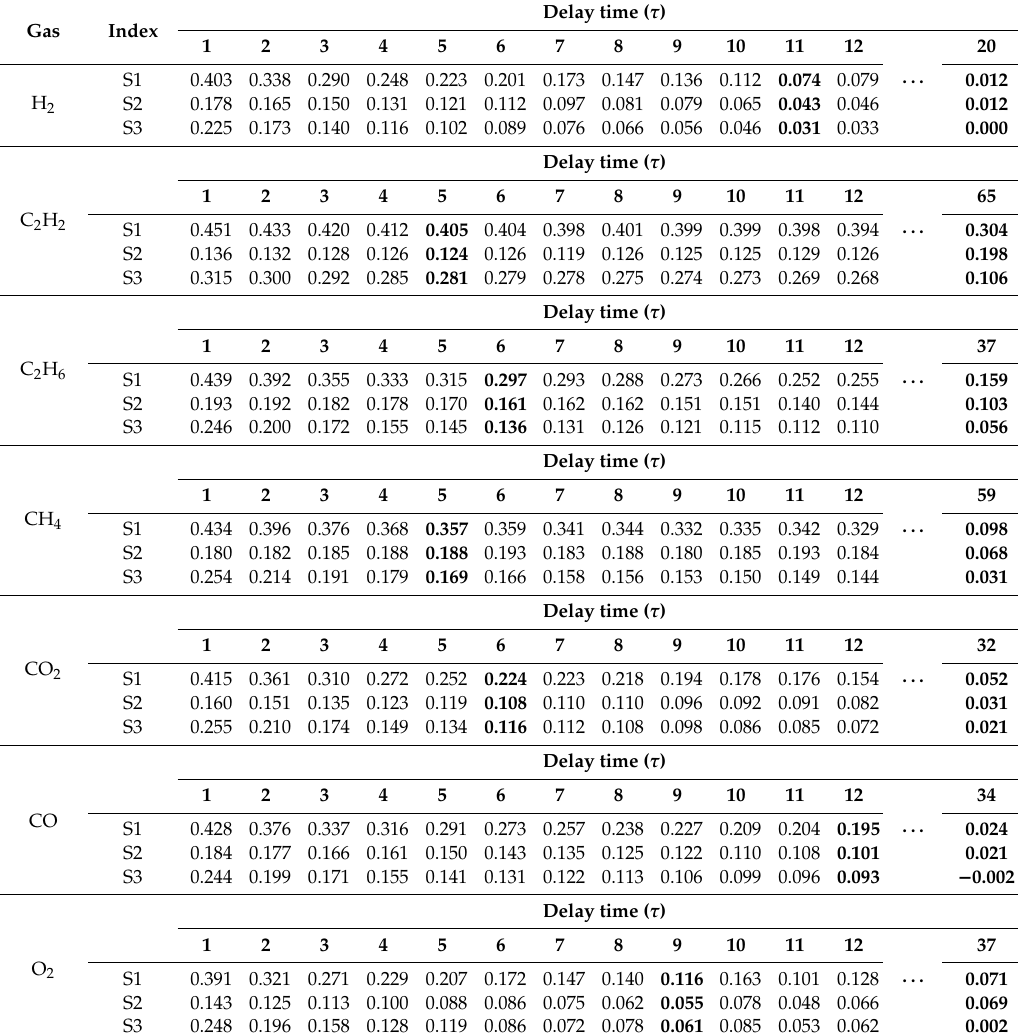
The bold values indicate global minimum of Scor and the first minimum point of ∆ Smean.